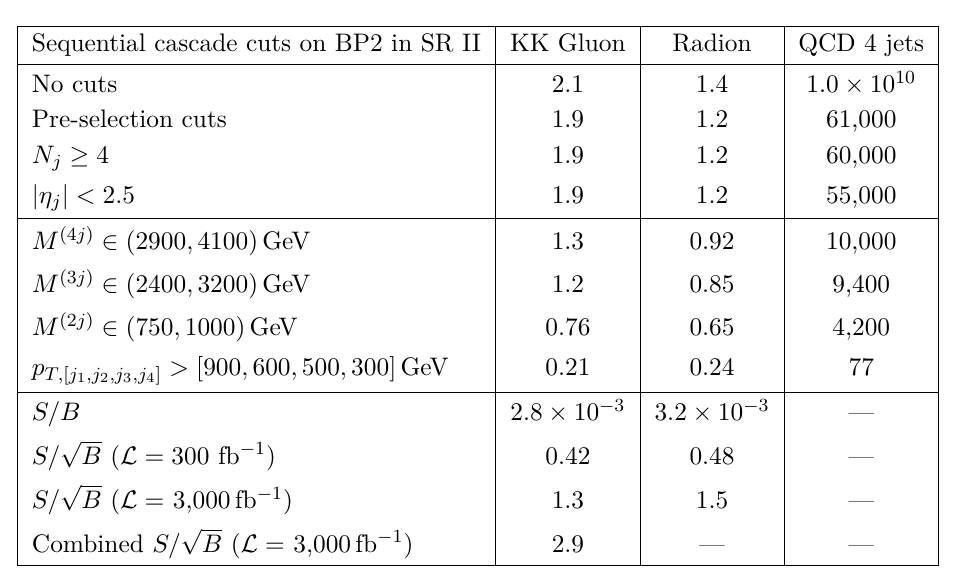
Table 5 . Cut flows of BP2 in SR II ( g grav = 6 , g g 3 TeV , and m ϕ = 1 TeV , see also table 1) and QCD 4-jet backgrounds. The same explanations including the pre-selection cuts as in the caption of table 4 are